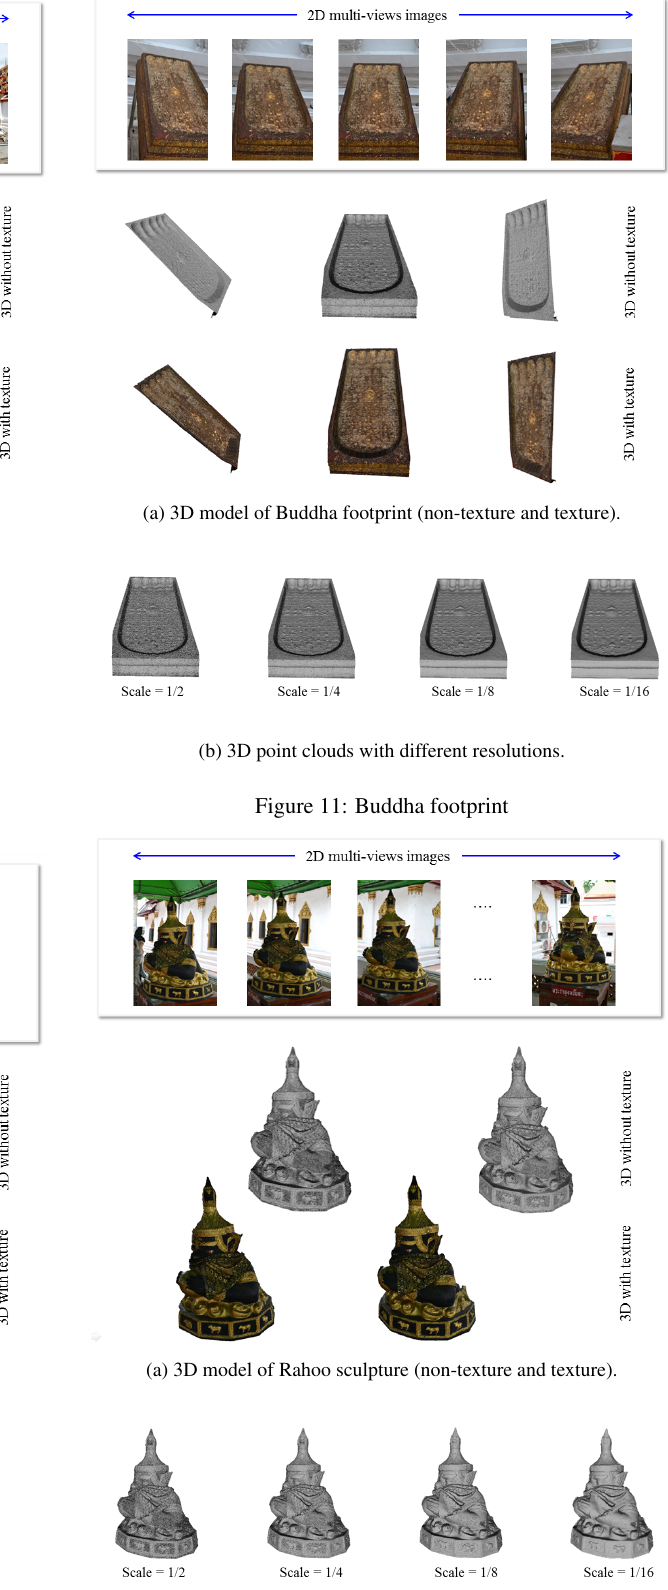
(b) 3D point clouds with different resolutions. Figure 10: Giant